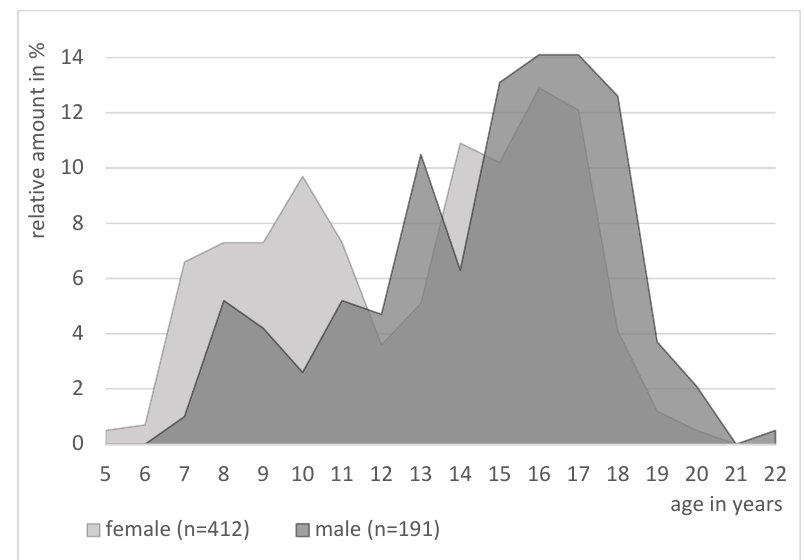
Figure 5. Frequency of those examined per age group in percent.